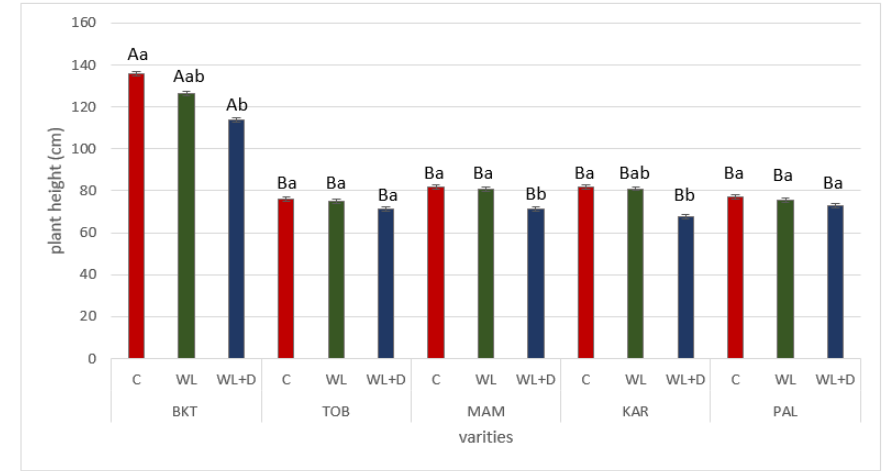
Figure 1. Plant heights of ‘Bánkúti 1201’ (BKT), ‘Mv Toborzó’ (TOB), ‘Mv Mambó’ (MAM), ‘Mv Karizma’ (KAR) and ‘Mv Pálma’ (PAL) varieties in the different treatments. ‘C’: control treatment; ‘WL’: waterlogging treatment; ‘WL + D’: combined treatment of waterlogging and drought. Capital letters indicate the statistical significance between the varieties at P ≤ 0.05 level; lowercase letters indicate the statistical significance between the treatments at P ≤ 0.05. Error bars represent honestly significant difference (HSD) 5% values (n = 3).